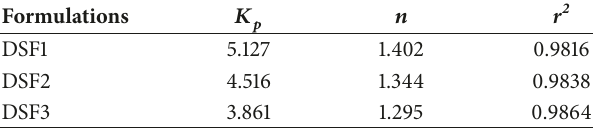
Table 3: Power law values of DSF